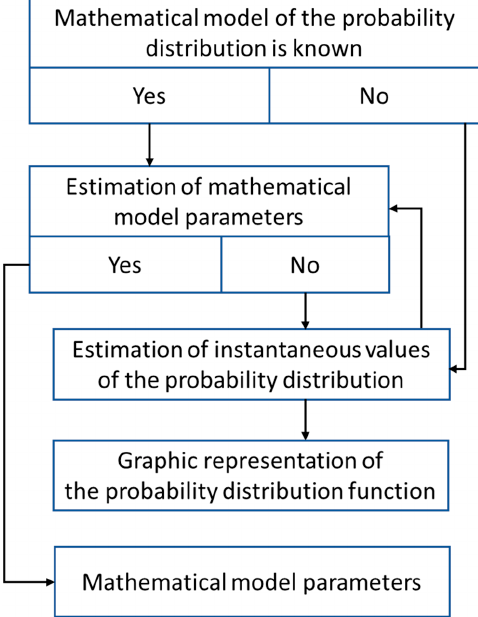
Figure 2. Flowchart of the correlation of parametric and non-parametric methods.